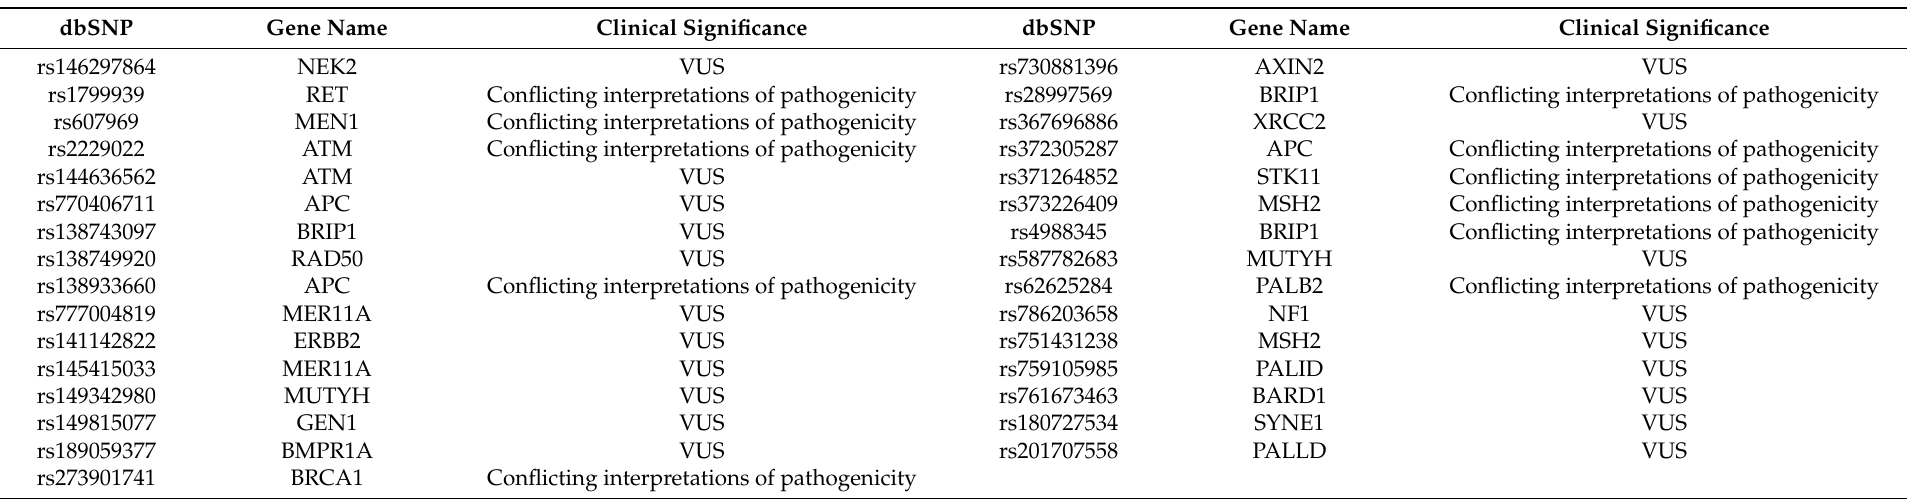
Table 5. List of variants of uncertain significance and variants of conflicting interpretation of pathogenicity identified with multi-gene panel